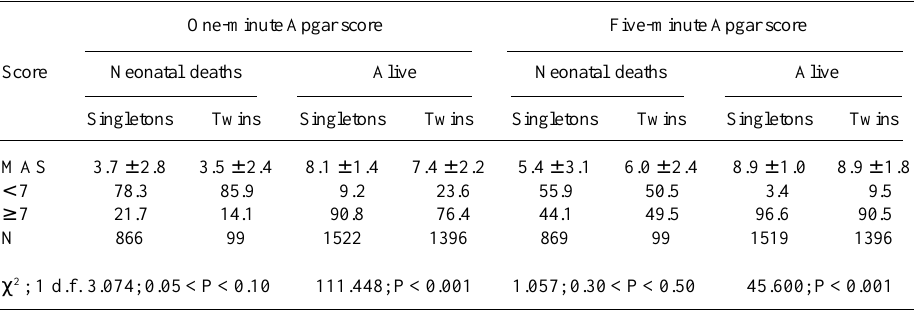
Table VII - Mean 1-min and 5-min Apgar scores (MAS) and percentage of early neonatal deaths and newborns alive for at least seven days after birth (singletons and twins) who had 1-min and 5-min Apgar scores of < 7 and ‡